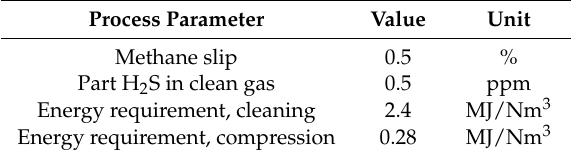
Table A9. Process data on water scrubber [31]. Clean gas is compressed to 230 bar.